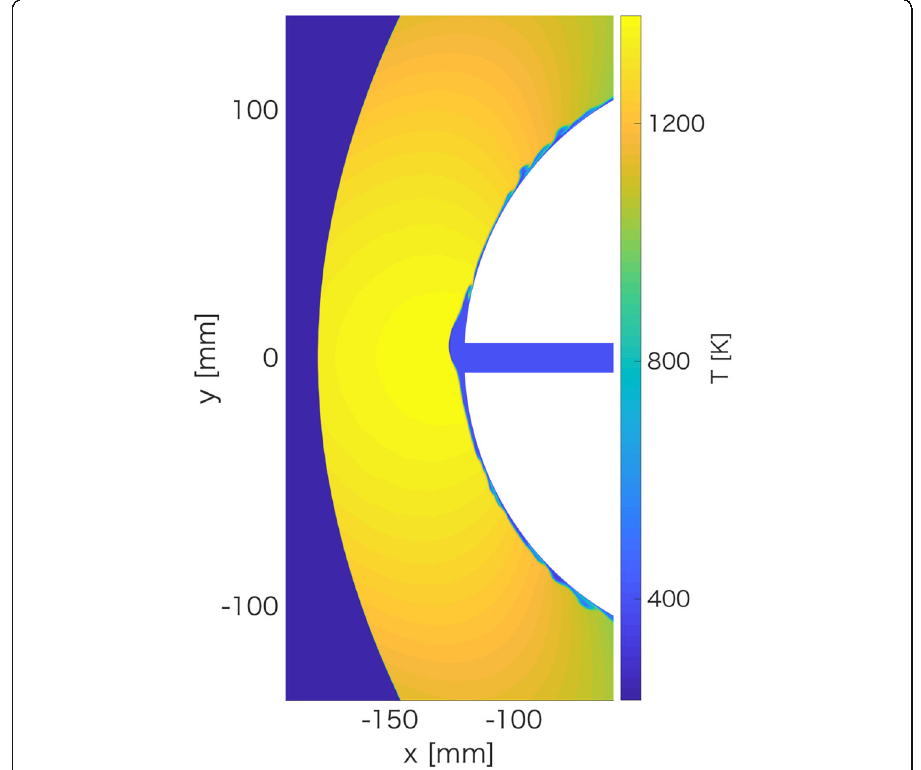
Fig. 4 A snapshot of the temperature field (Case-A, Model-1, Ω = 0°, 8.8 × 10 5